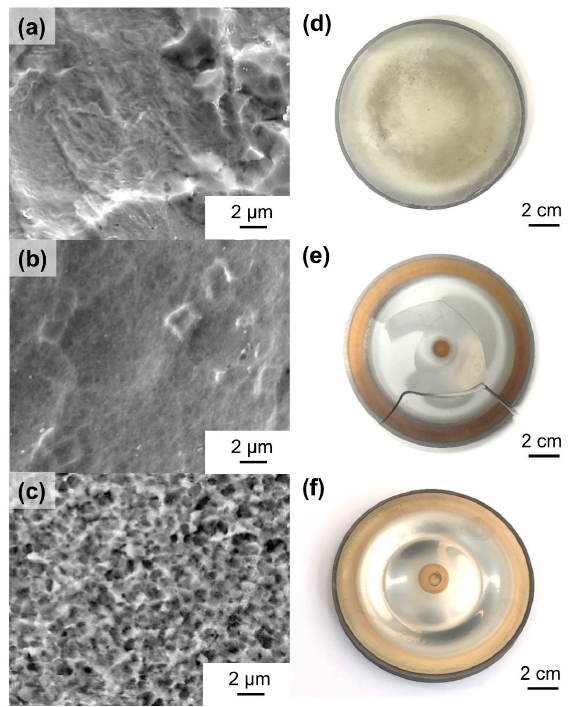
Figure 5. ( a ), ( b ), ( c ) SEM results for surfaces after TFMG deposition of the ( a ) cast target, ( b ) amorphous target, and ( c ) crystalline target, respectively. ( d ), ( e ), ( f ) Surface photographs before TFMG deposition of ( d ) cast target, ( e ) amorphous, and ( f ) crystalline targets, respectively.